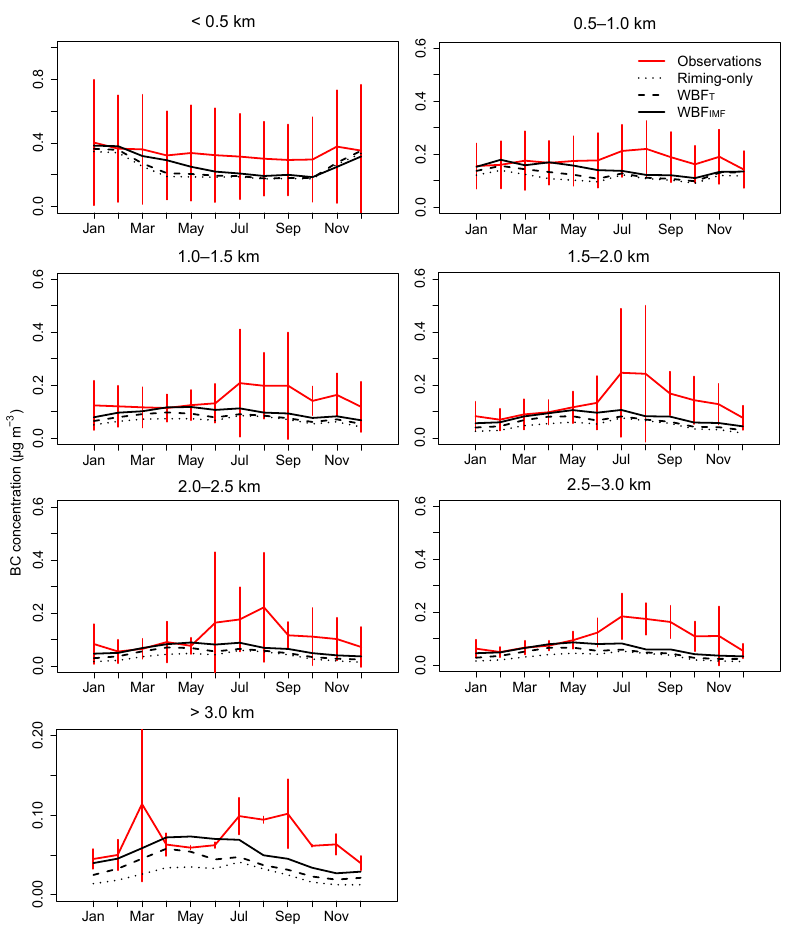
Figure 5. IMPROVE-observed (red solid line) and GEOS-Chem-simulated (dotted: riming-only; dashed: WBF T ; solid black: WBF IMF ) seasonal variation in monthly mean BC concentrations (µgm − 3 ) for 2007–2009. Also shown are standard deviations of observations (error bars).